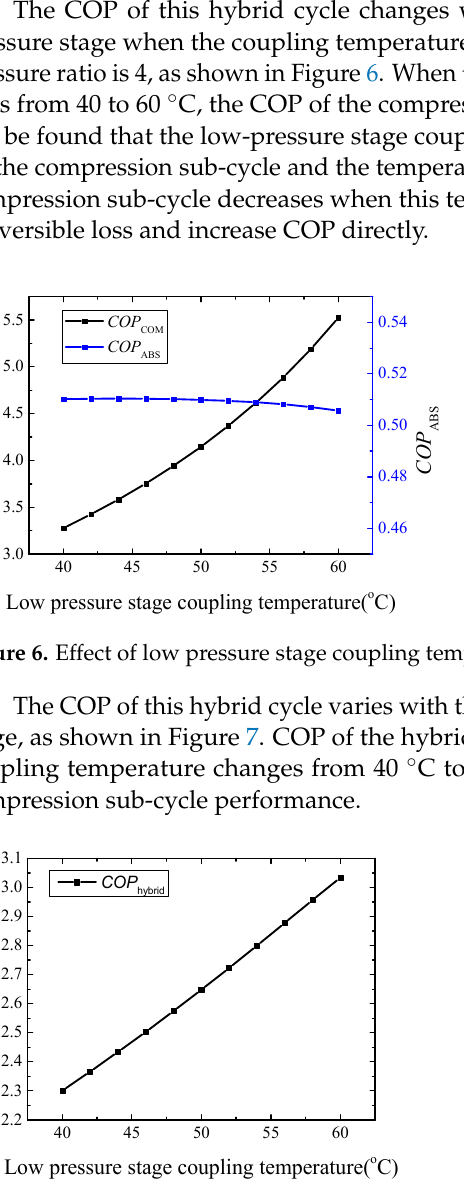
Figure 7. Effect of low pressure stage coupling temperature on coupling cycle COP.